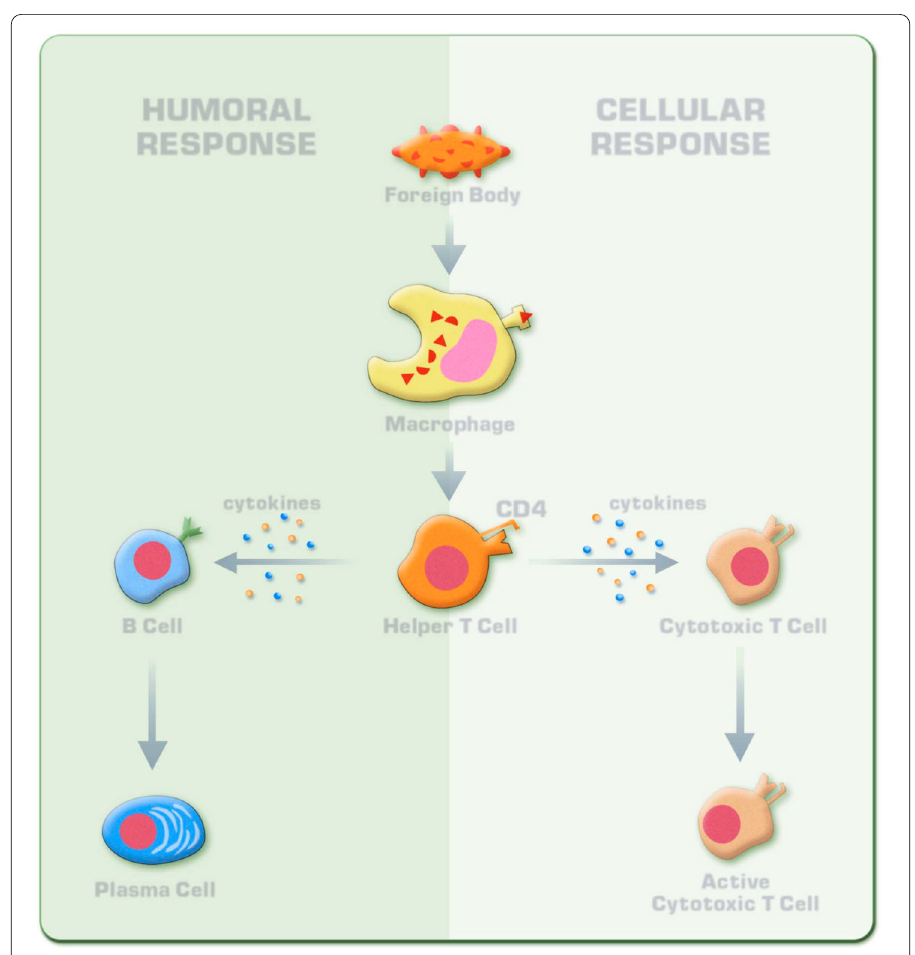
Figure 1 Specialized Macrophage cell which ingest foreign antigens invading the host